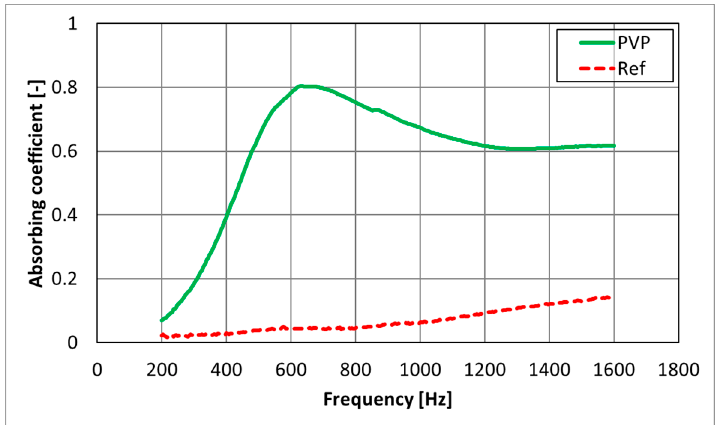
Figure 10. Absorbing coefficients for PVP nanofiber textile and the reference material.